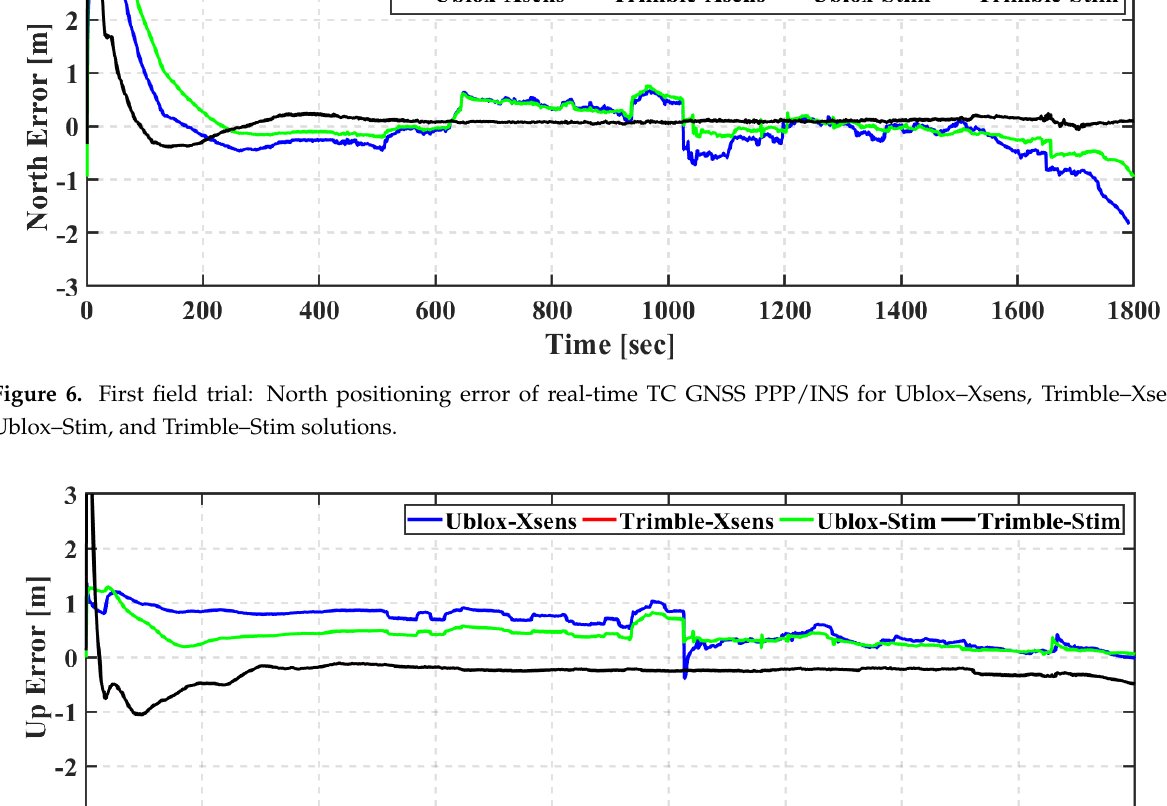
Figure 5. First field trial: East positioning error of real-time TC GNSS PPP/INS for Ublox–Xsens, Trimble–Xsens, Ublox– Stim, and Trimble–Stim solutions.